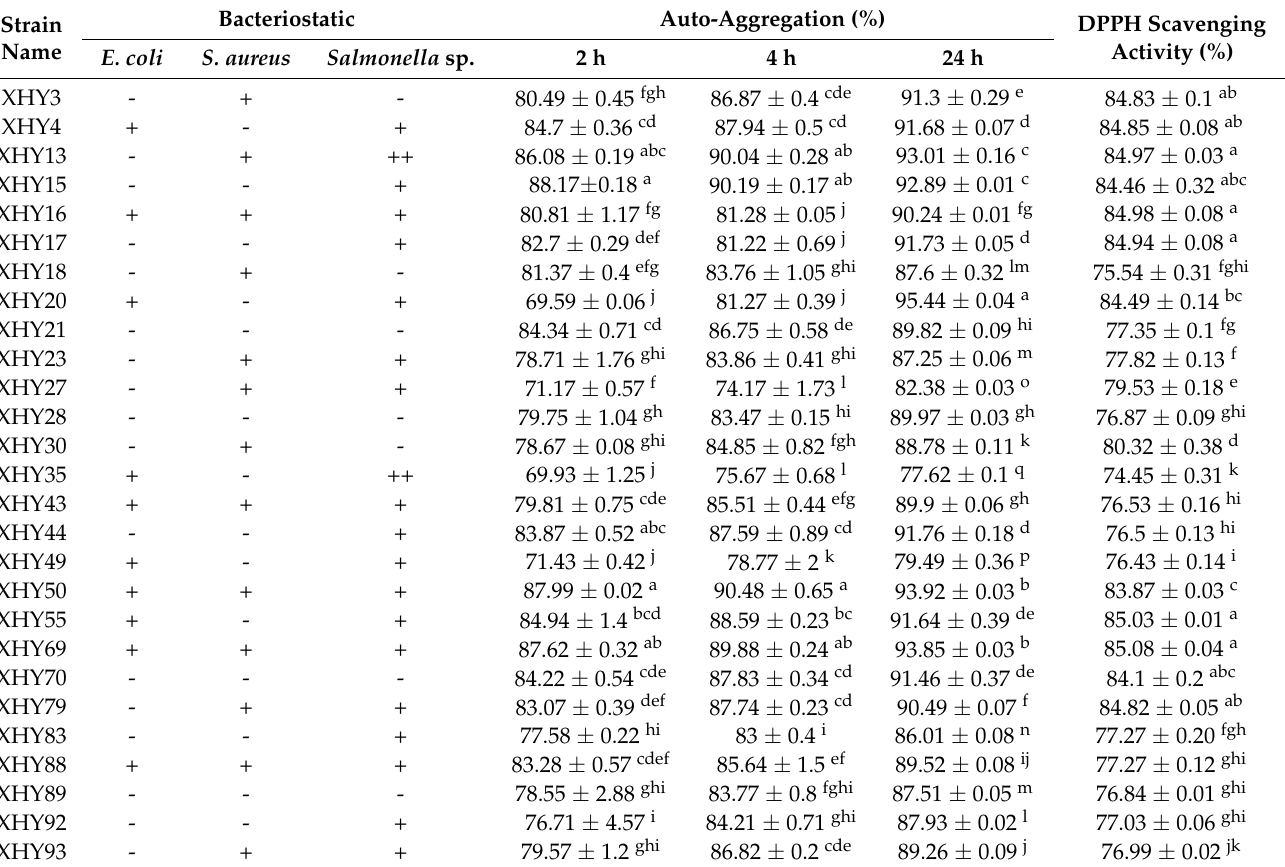
Table 2. The bacteriostatic, auto-aggregation, and antioxidant activities of 27